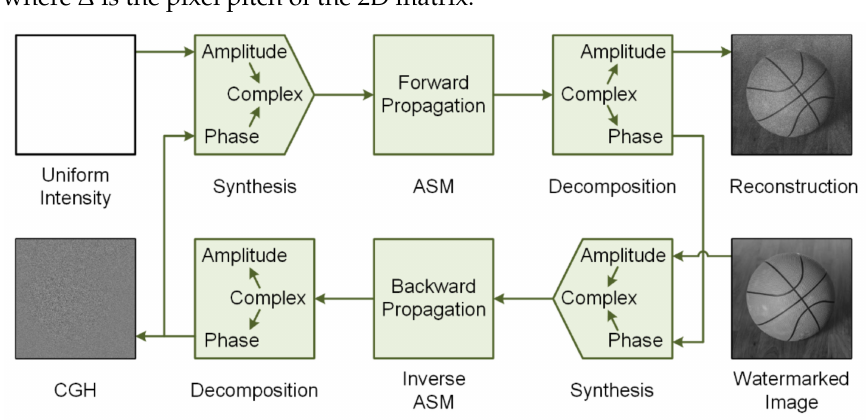
Figure 3. The calculation of the CGH by the